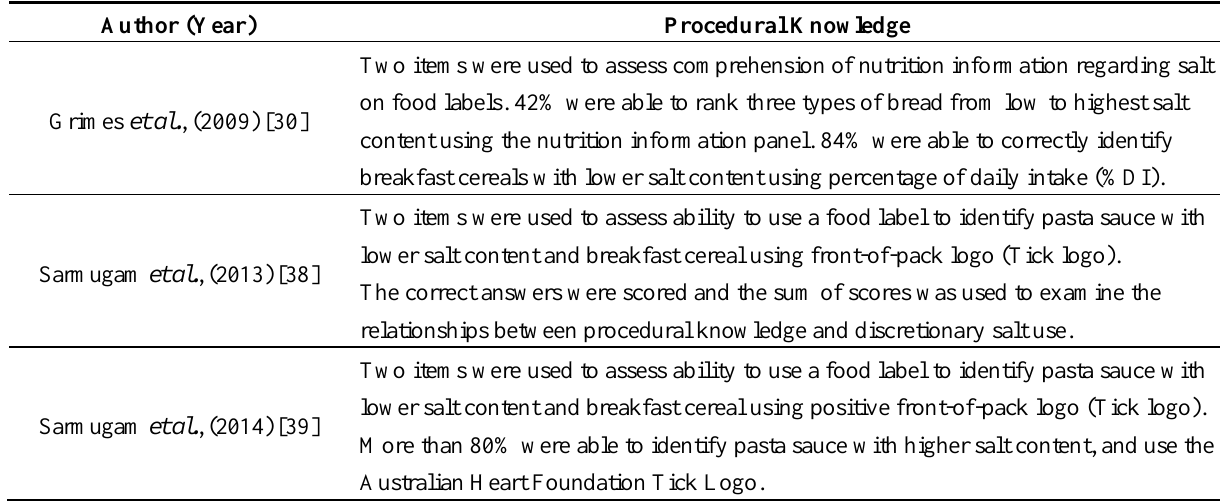
Table 3. Summary of findings on assessment of procedural salt